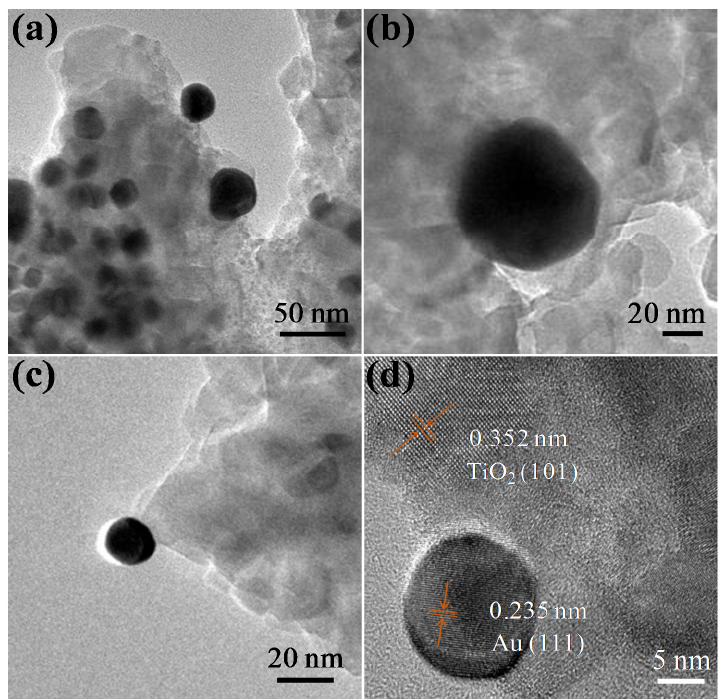
Figure 7. ( a – c ) TEM and ( d ) HRTEM photographs of 2.1 wt% gold-dicyanodiamine composite (GDC)-directed dual particle-size AuNPs/TiO 2 composite. Nanomaterials 2019 , 9 , x